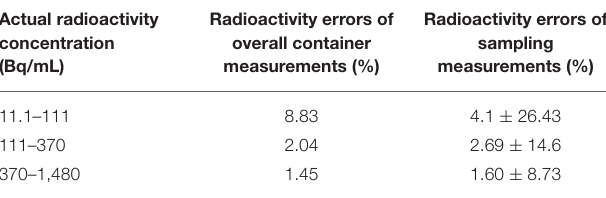
TABLE 1 | Radioactivity errors between measured radioactivity and actual